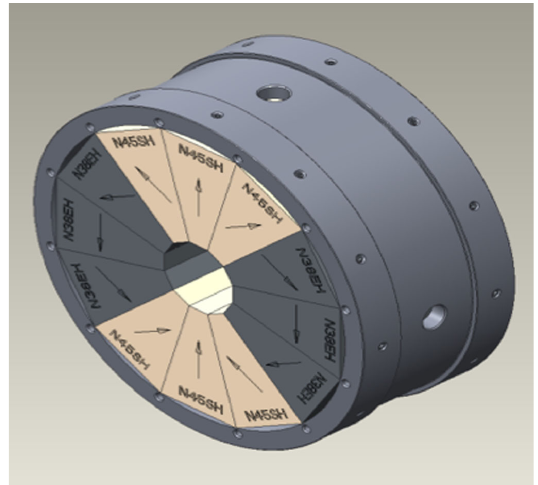
FIG. 16. Model of the individual magnet assembly. Magneti- zation directions are shown by arrows. Different colors corre- spond to different PM materials.